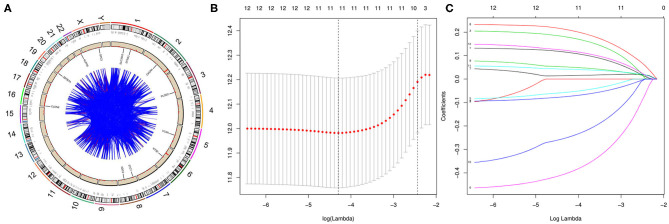
Circos plot and the least absolute shrinkage and selection operator (LASSO) Cox regression analysis for construction of the final prediction model. (A) Circos analysis of glycolysis-related genes from the TCGA whole RNA sequencing. The outermost layer displays the locations of all 326 glycolysis-related genes on the 23 human chromosomes. The middle layer shows the HR values derived from the univariate Cox regression analysis, thus identifying 12 OS-related GRGs, which were illustrated in Table 1. The inner layer shows the PPI network, similar to Figure 2B, whose medium confidence of minimum required interaction score is 0.9, <0.99 is blue, and >0.99 is red. (B) Selection of the optimal parameter (lambda) in the LASSO model; dotted vertical lines were drawn at the optimal values by using the minimum criteria. (C) LASSO coefficient profiles of the candidate OS-related GRGs with nonzero coefficients determined by the optimal lambda. A coefficient profile plot was produced against the logλ sequence.